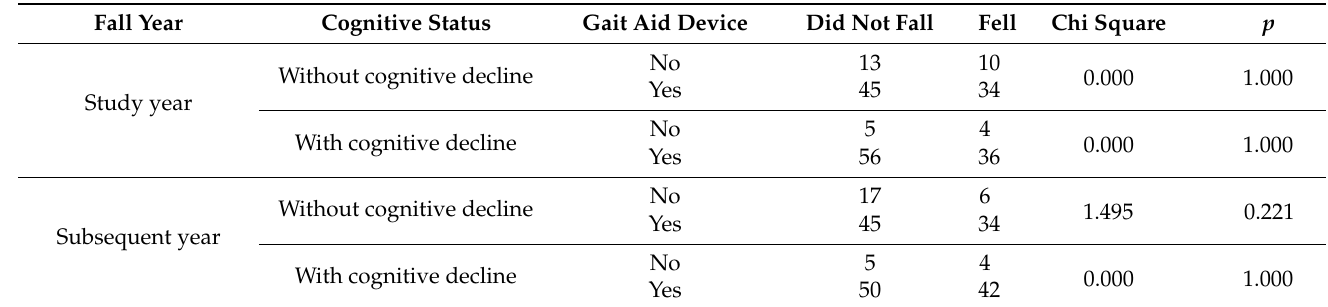
Table 6. Results of the application of the chi-square test to use of gait aid devices regarding both the existence of a fall episode throughout the study year and the subsequent year, and the cognitive status of the older